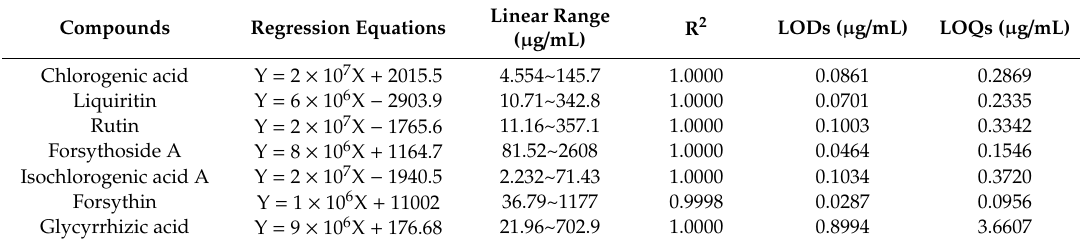
Table 1. The regression equations, Limit of Detections (LODs) and Limit of Quantity (LOQs) of seven compounds.